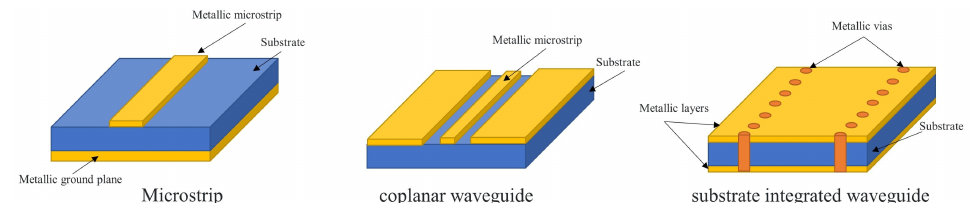
Figure 2. Feeding methods for the dielectric resonator antenna.